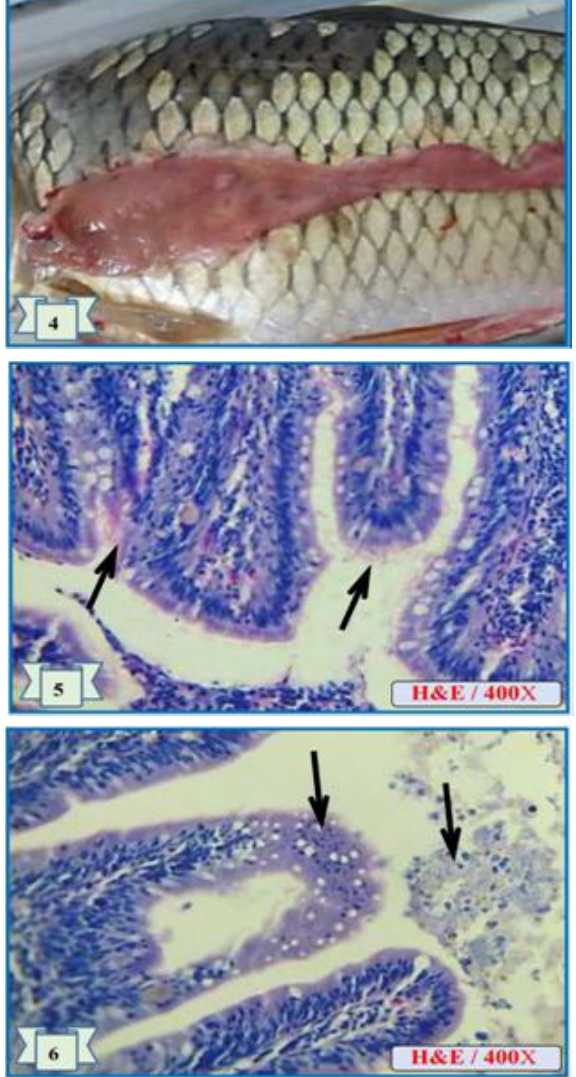
Figure, 1: Acidity and Alkaline of rearing pond of common carp. Grossly show [1] necrosis and destruction of scales behind the gills, and [2] extend to other body part, and [3] sever congestion of gills, [4] the intestines show mucinous exudate. Microscopically there is [5] mucinous degeneration in enterocytes lining the intestinal villi with hyperplasia of goblet cells (arrow), also [6] shows sloughing of cellular debris in the lumen